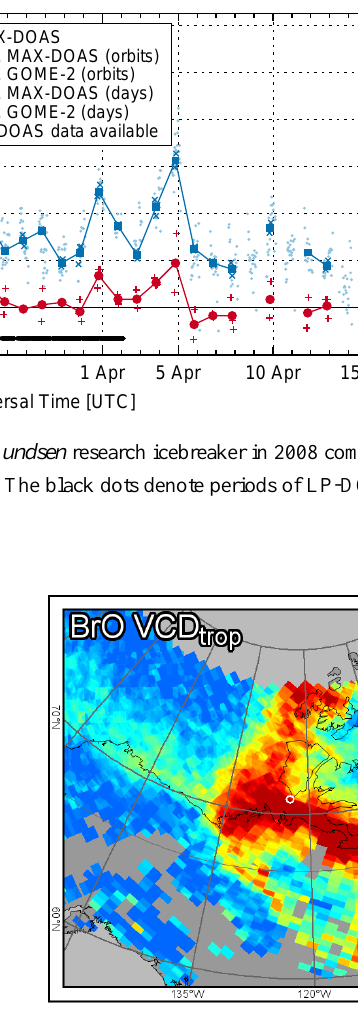
Fig. 15. Satellite map of tropospheric BrO VCDs measured by GOME-2 on 14 March 2008. The circle denotes the position of the Amundsen icebreaker. Further maps of the Amundsen campaign are shown in the